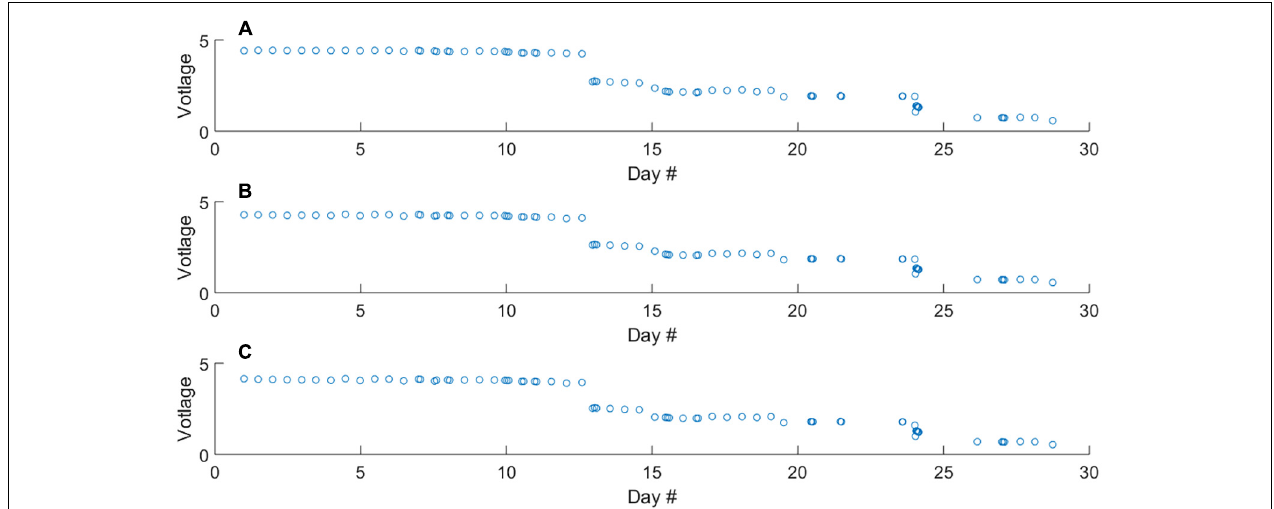
FIGURE 3 | Raw voltage output of the measurement photodiode throughout the deployment during the measurement of the blank (A) , 0.46 µ M standard (B) , and 1.00 µ M standard (C) solutions. The differences in raw voltage for respective blank and standard measurements are too small to see, Figure 4 contains absorbance values.